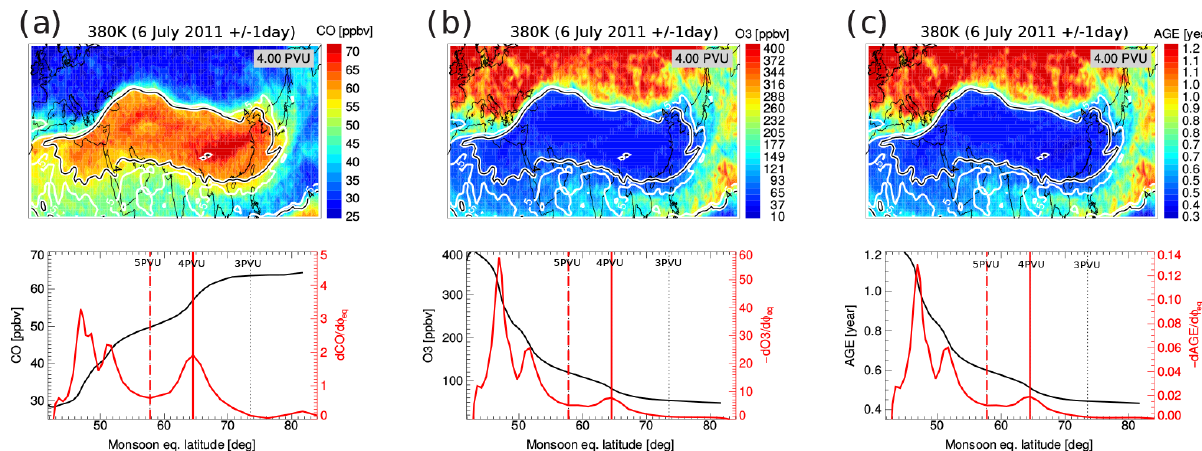
Figure 11. (a) Map of CO from CLaMS on the 380K isentrope, with the thick white contour showing the PV-value of maximum CO- gradient, the black contour showing the PV-value of maximum PV-gradient (thin white line shows 5PVU), averaged between 5 and 7 July 2011 at 380K. The bottom panel shows CO from CLaMS vs. monsoon centered equivalent latitude (black), and the respective gradient (red). (b) Same for ozone from CLaMS, and (c) for mean age from CLaMS. (The PV values of the maximum gradient are given in the upper panels.)